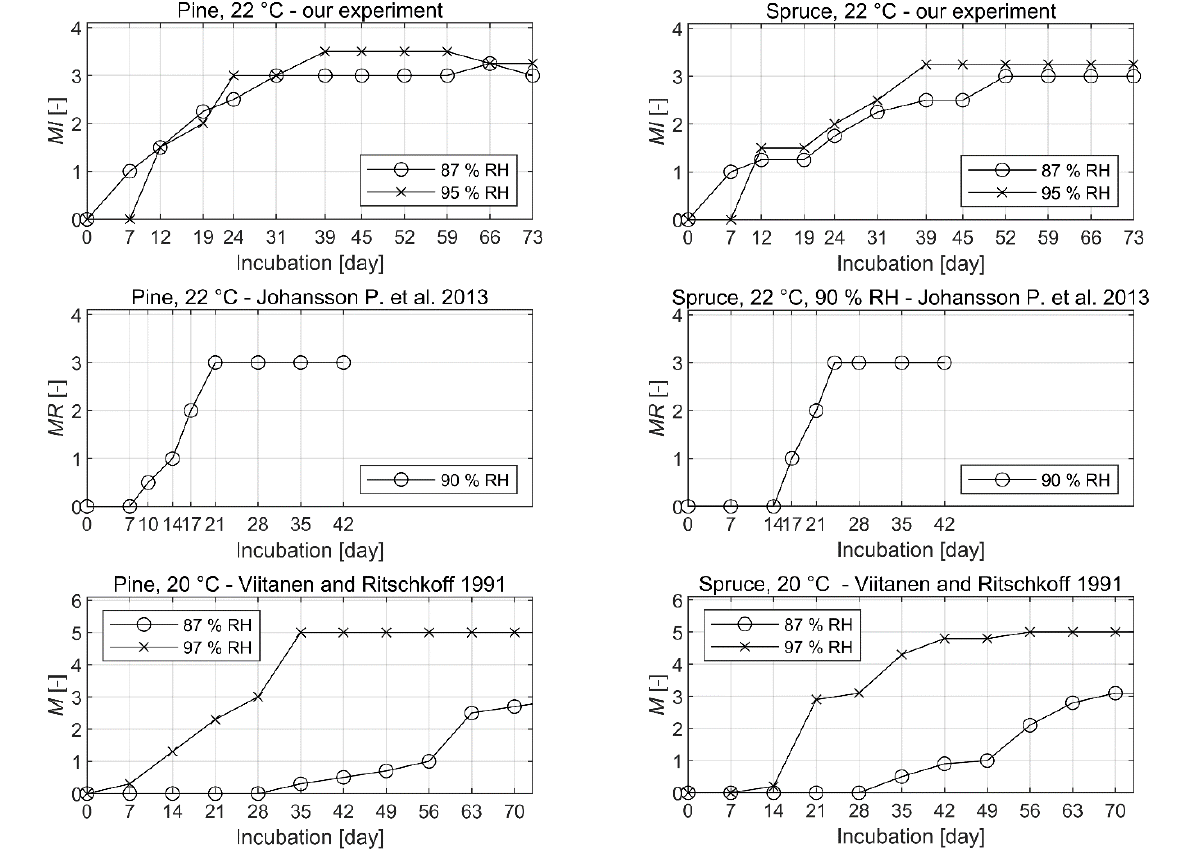
Figure 4. Comparison of experimental mold growth curves (our experiment—mean mold growth curves calculated from specimens with radial and tangential surfaces, data of Johansson et al. 2013 [12], data of Viitanen and Ritschkoff 1991 [19]. The time for the first microscopic signs of molds corresponds to MR = 1 and M = 1. The time for the first macroscopic signs of molds corresponds to MR = 3 and M = 3.